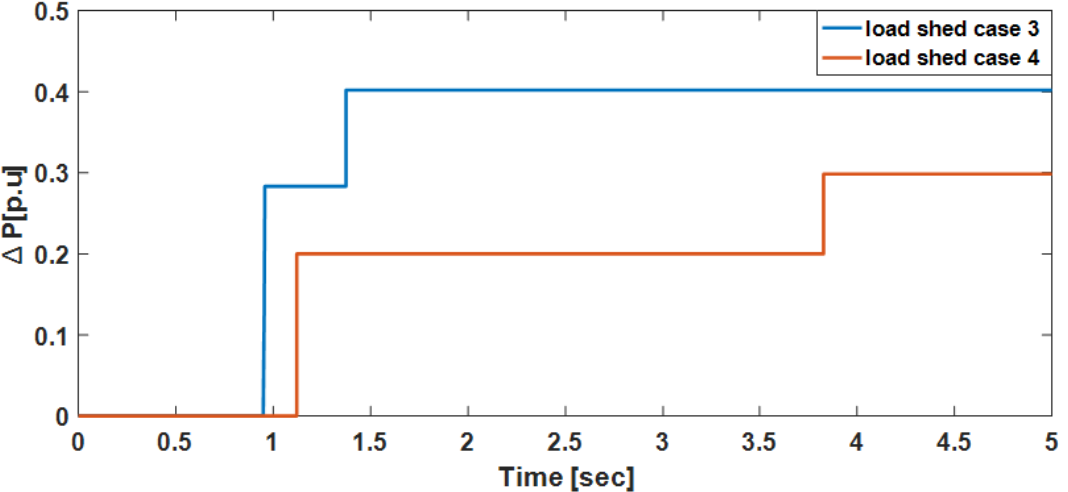
Figure 8. The amount of load to be shed in second scenario: a comparison between cases 3 & 4.